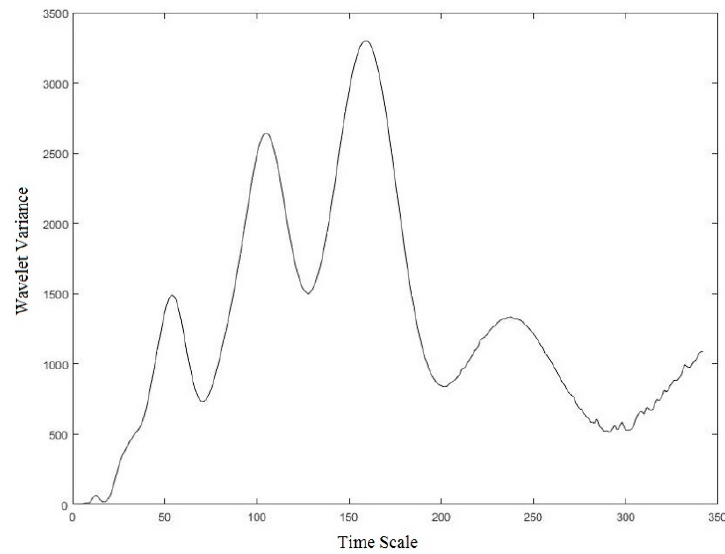
Figure 13. SPEI12 wavelet variance map.